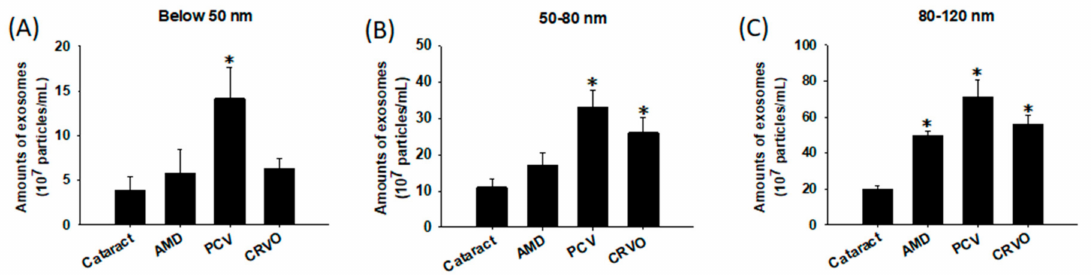
Figure 7. Size distribution of exosomes in different retinal diseases. Extracellular vesicles (EVs) were isolated from the aqueous humor of patients with eye diseases, including cataracts, age-related macular degeneration (AMD), polypoidal choroidal vasculopathy (PCV), and central retinal vein occlusion (CRVO), and analyzed using nanoparticle tracking analysis (NTA). Exosomes were subsequently classified into different size ranges as follows: ( A ) exomeres (below 50 nm), ( B ) small exosomes (Exo-S; 50–80 nm), and ( C ) large exosomes (Exo-L; 80–120 nm), and obtained the amounts of different diseases. The data are expressed as the mean ± SE of 6–7 samples per group. * p < 0.05 compared to the cataract